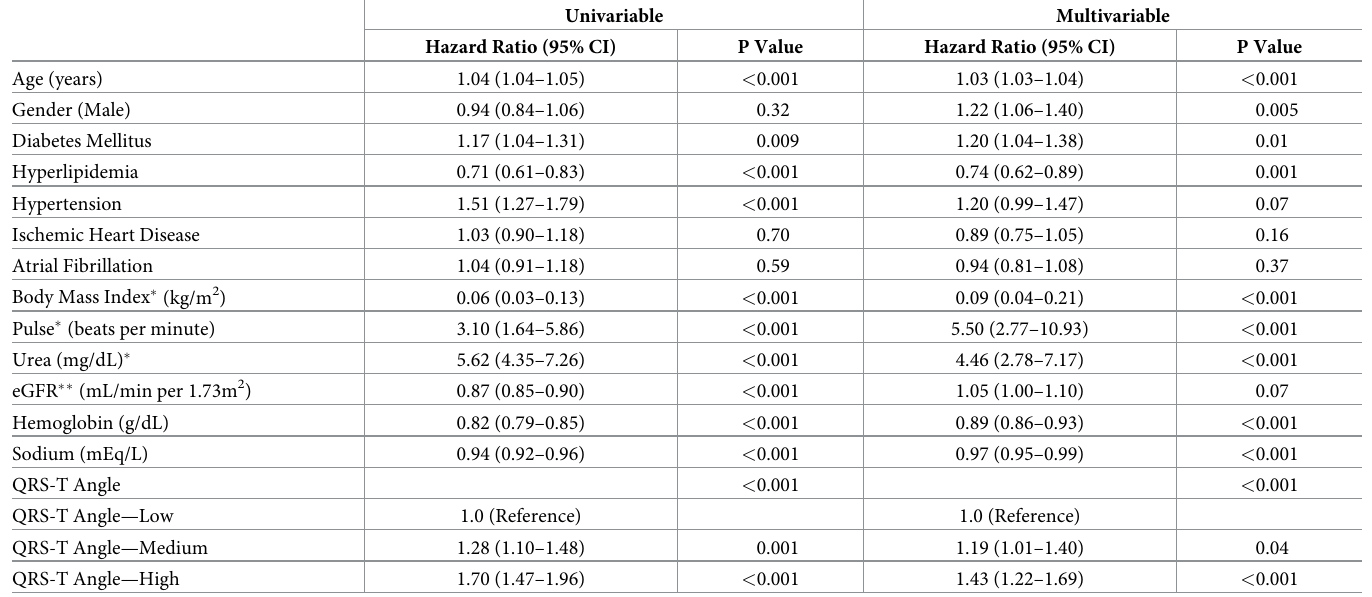
Fig 2. Kaplan Meier survival analysis according to baseline QRS-T angle category stratified by gender. The tertile QRS-T angle percentiles were 40˚ and 103˚ in women and 51˚ and 125˚ in men. The estimated cumulative survival rate at the median follow-up time was reduced with increasing baseline QRS-T angle category; 67.9 ± 1.5% vs. 61.2 ± 1.5% vs. 52.1 ± 1.6%, P < 0.001. https://doi.org/10.1371/journal.pone.0194520.g002 Table 2. Predictors of mortality by Cox regression